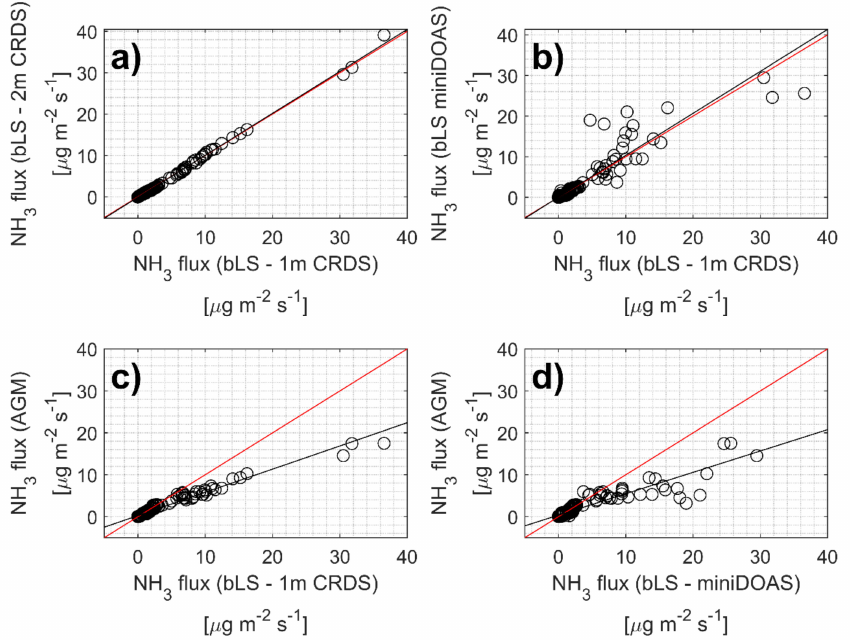
Figure 7. Correlation between the NH 3 fluxes estimated by ( a ) CRDS-bLS 1 m and CRDS-bLS 2 m, AGM in the August campaign. The black lines are Deming regression lines, and the red lines are 1:1 lines. The regression coefficients are shown in Table